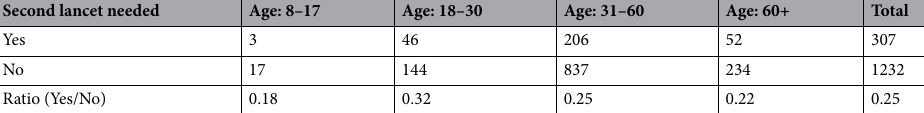
Table 3. Number of participants in four age groups that required the second lancet to complete the test.